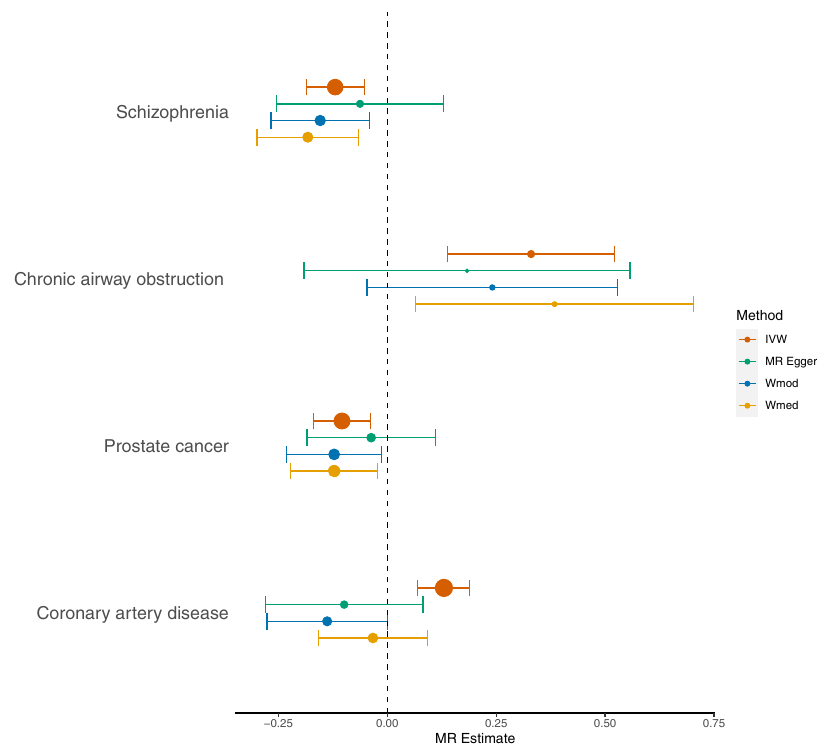
Fig. 6 Two-sample Mendelian Randomisation results. Schizophrenia, chronic airway obstruction and prostate cancer survived Bonferroni threshold with consistent effect direction across sensitivity tests, many of which are also nominally signi fi cant. Coronary artery disease is presented here as a disease of interest. The size of the point represents the precision of the estimate (1/SE). The points are the beta estimates from the MR analyses and the error bars are the 95% con fi dence